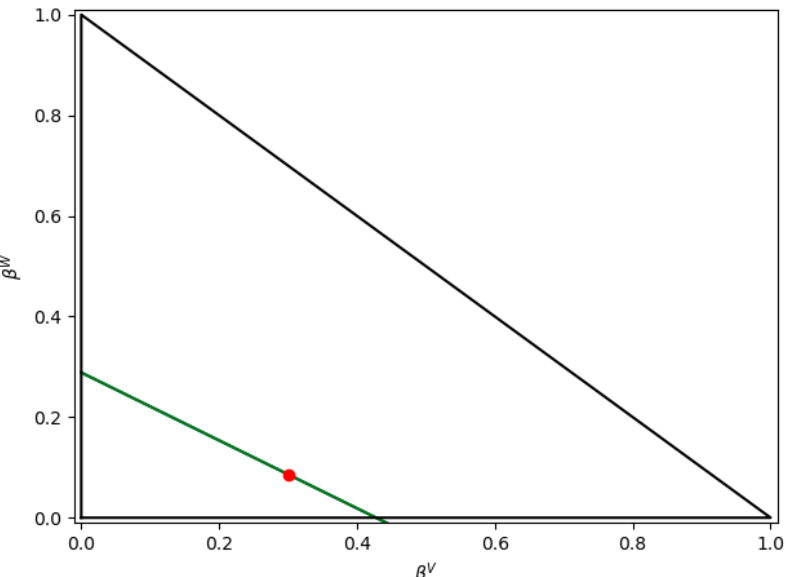
Figure 11. Lines for RR y = 0 and RR w = 0 at T = 110 ◦ C. Note: red point represents HYSYS solution.